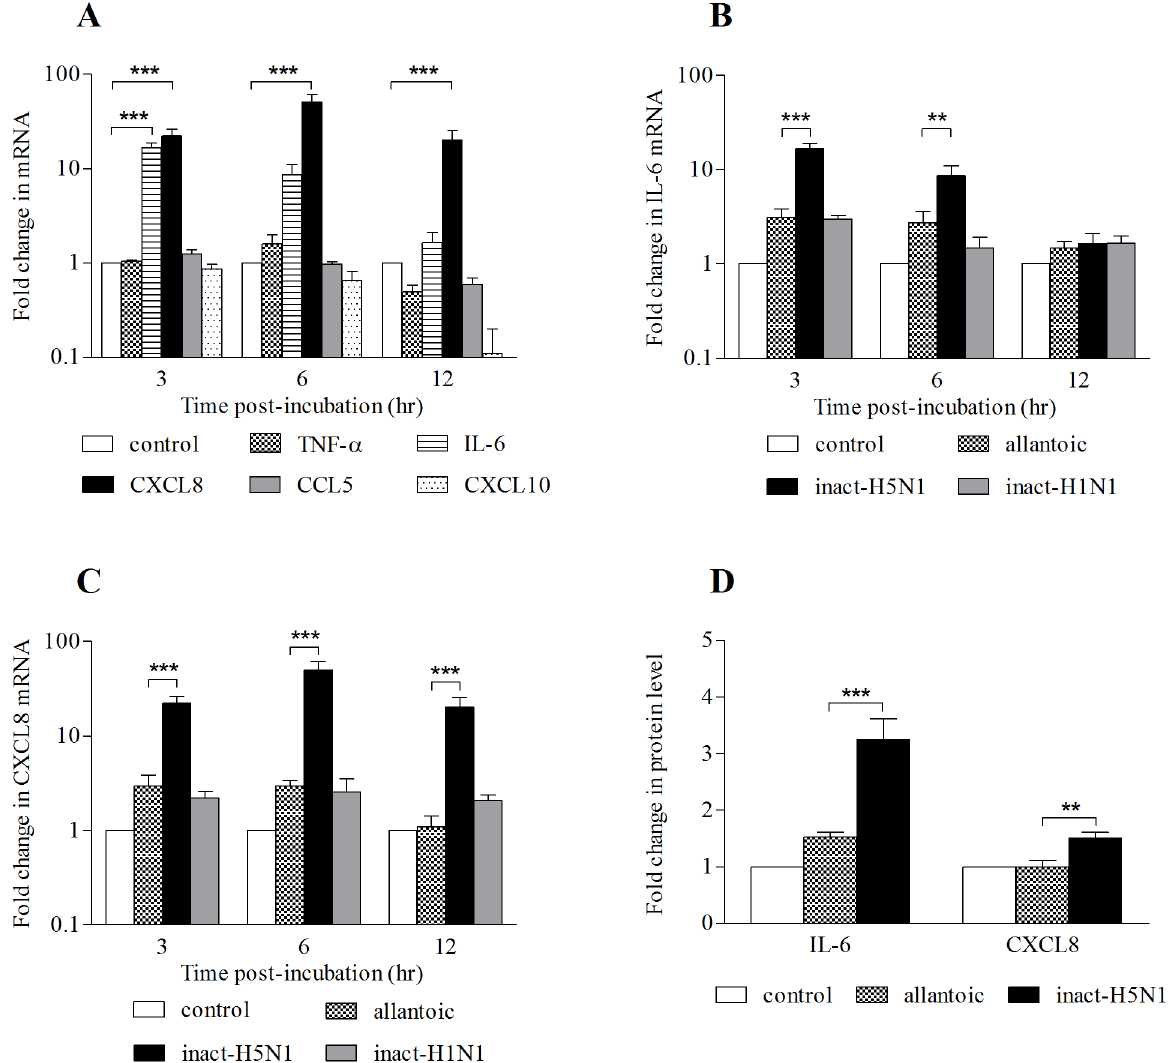
Fig 1. Inactivated-H5N1 increasesmRNA of IL-6 & CXCL8. ( A) Fold changes(log scale) in mRNA level of TNF- α , IL-6, CXCL8, CCL5 or CXCL10 in 16HBE14o- cells treated with inactivated-H5N1(20 μ g/ml hemagglutinin) or untreatedcells (control) for 3 hr, 6 hr or 12 hr. (B) Fold changesin mRNA expressionlevel of IL-6 and (C) CXCL8 in untreated cells (control), allantoicfluid, inactivated-H5N1 or inactivated-H1N1. (D) Fold changesin protein concentrations of IL-6 and CXCL8 in cell-free culture medium in untreatedcells (control) or treated for 36 hr with allantoicfluid or inactivated-H5N1 were analyzedby Bio-plexassay. Data were normalizedagainst control untreatedgroups. Valuesare means ± SEM from at least 3 sets of experiments. * , ** and *** indicates p < 0.05, p < 0.01